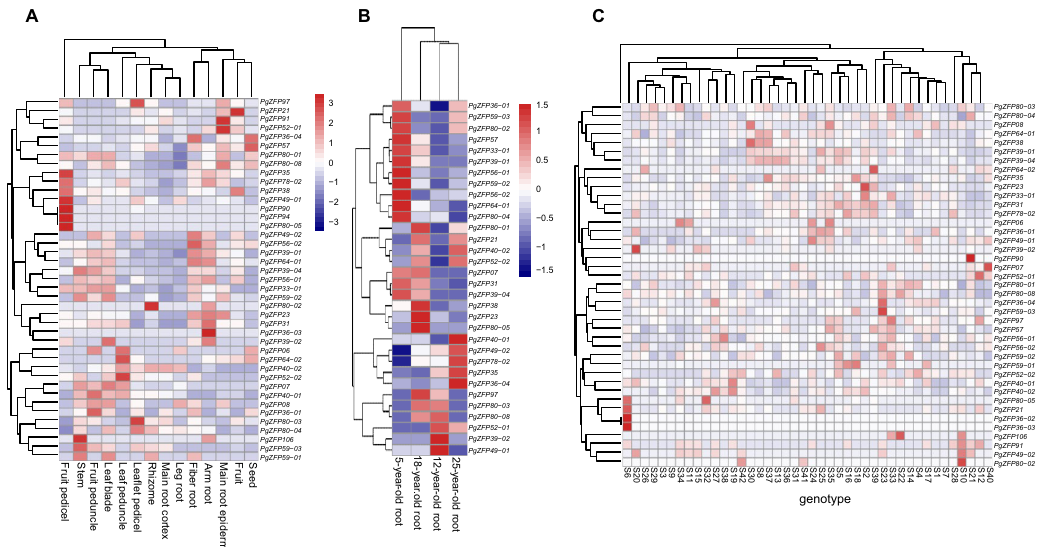
Figure 5. Expression heatmaps of the PgZFP gene transcripts in 14 tissues ( A ), four different aged roots ( B ) and the 4-year-old roots of 42 genotypes ( C